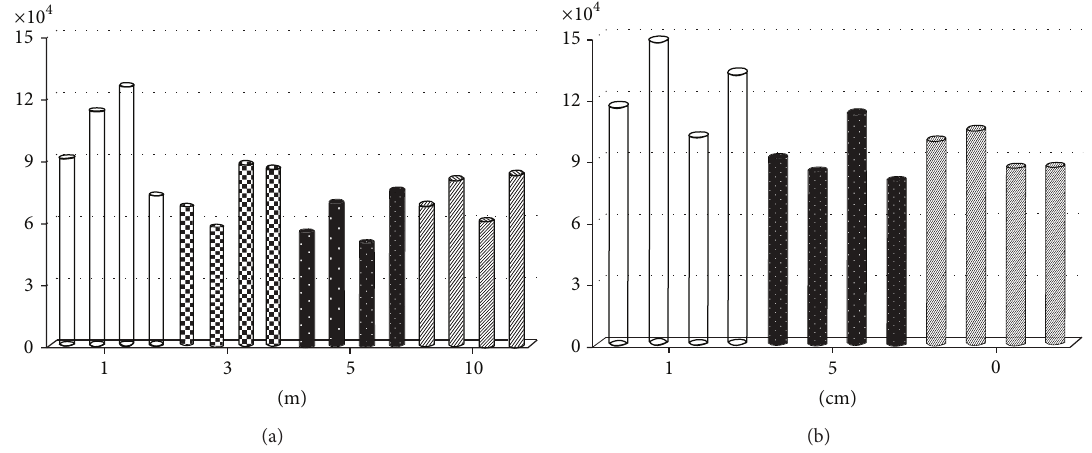
Figure 5: Total counts of the radiation sensor (a) according to the length of the transmitting optic fiber and (b) according to the distance between the radiation sensor and source.